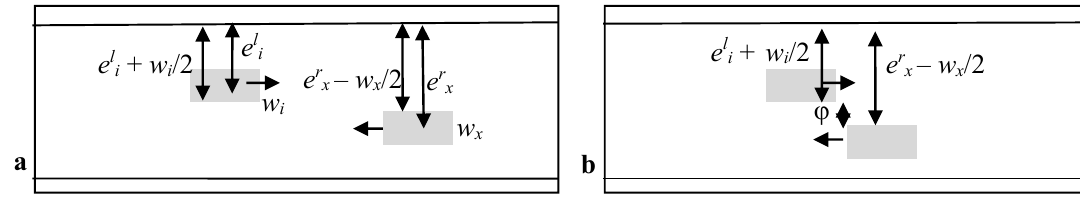
Figure 6. Notations for deciding the turn of V x with V i overtaking V j . Case involving right turn: ( a ) Initial Positions; ( b ) Overtake Positions.